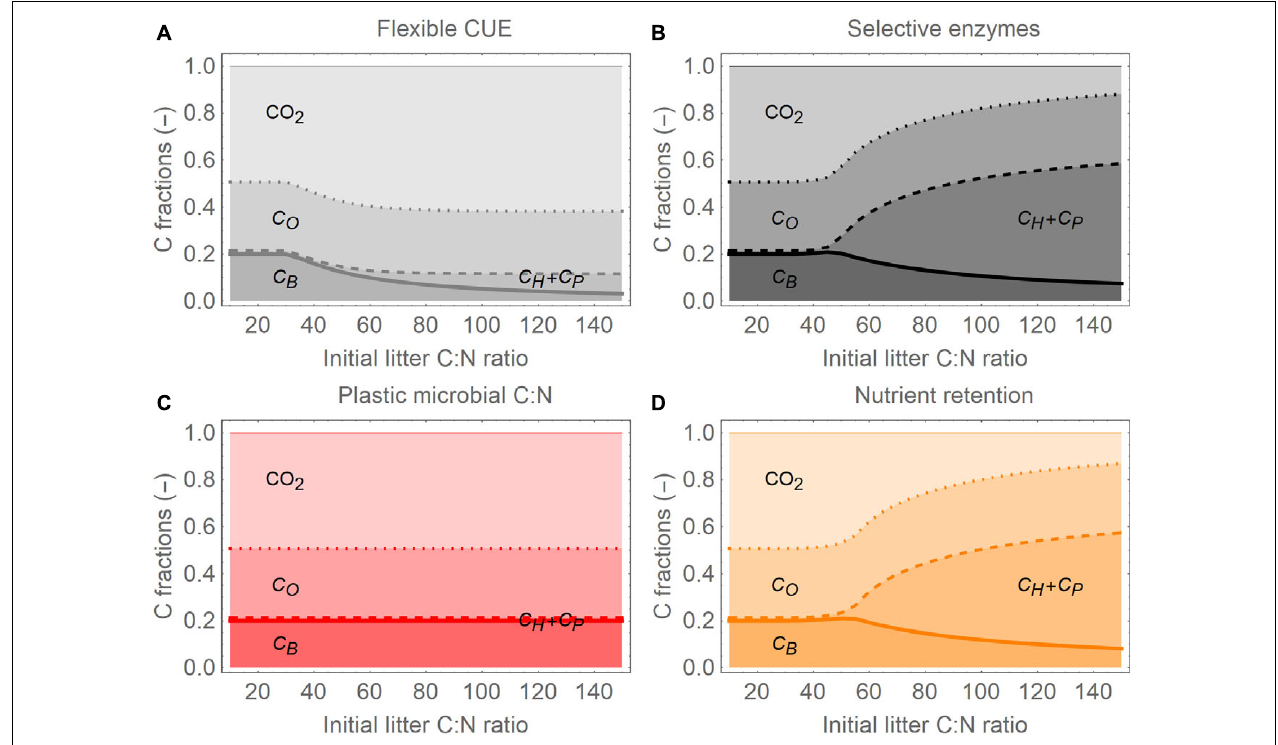
FIGURE 4 | Partitioning of C among litter components and CO 2 (including microbial respiration and the products of C O decomposition) when the initial litter C:N ratio is varied, for the four resource use modes, 1 year after the start of the incubation: (A) flexible CUE, (B) selective enzymes, (C) plastic microbial C:N ratio, and (D) nutrient retention (color scheme as in Figures 2 , 3 ). The total litter C:N is varied, but protein and microbial C:N are fixed, so that moving left to right on the abscissa is equivalent to increasing the initial carbohydrate fraction from 0.3 to 0.7, and decreasing the protein fraction from 0.4 to nearly zero. For clarity, carbohydrate and protein C are combined into a single C fraction, C H + C P ; parameter values and initial conditions are as in Figure 3 , except total litter C:N, which is varied along the